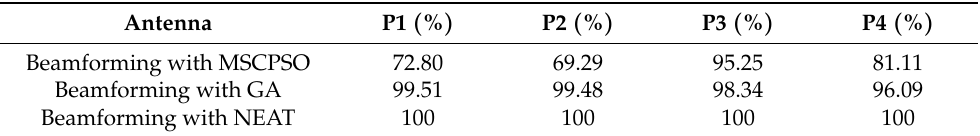
Table 5. Percentage of scenarios where the antenna array outperforms the isotropic antenna for different